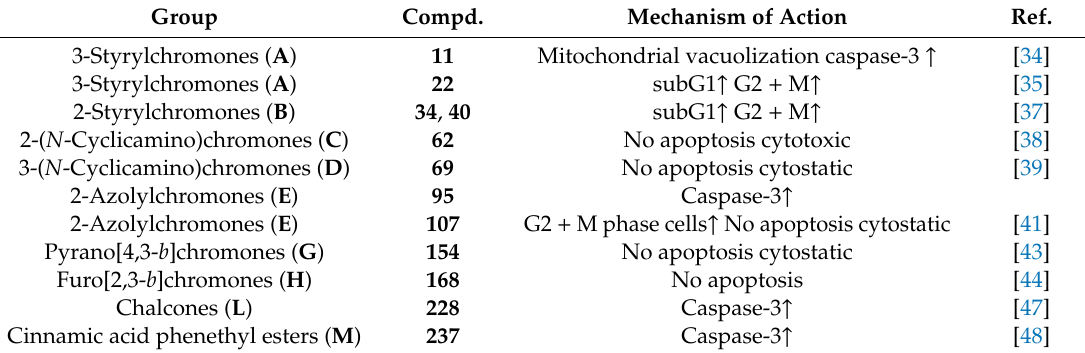
Table 6. The most active compounds in each group do not necessarily induce apoptosis in human oral squamous cell carcinoma (OSCC) cell line.